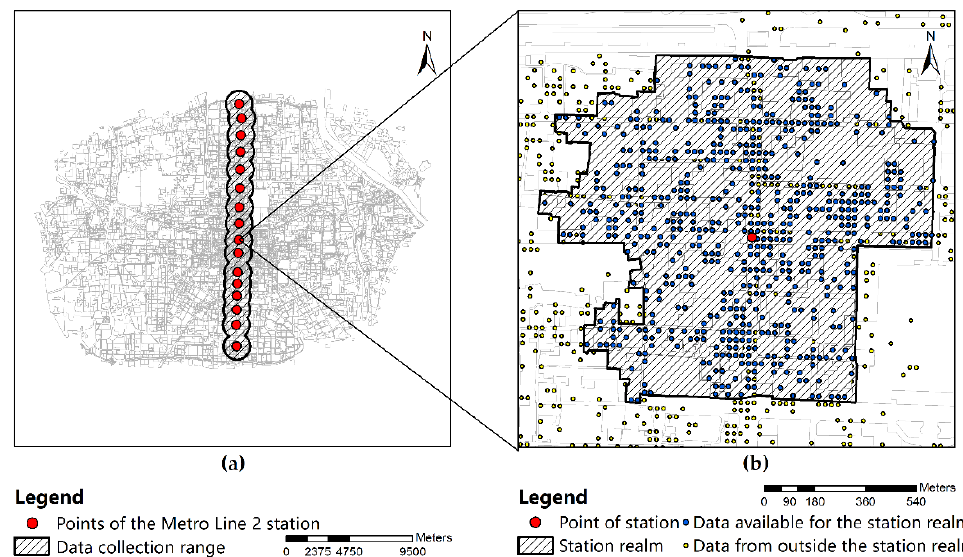
Figure 7. Data collection area and partial data. ( a ) Data collection area of Metro Line 2; ( b ) Point data distribution of population activities.